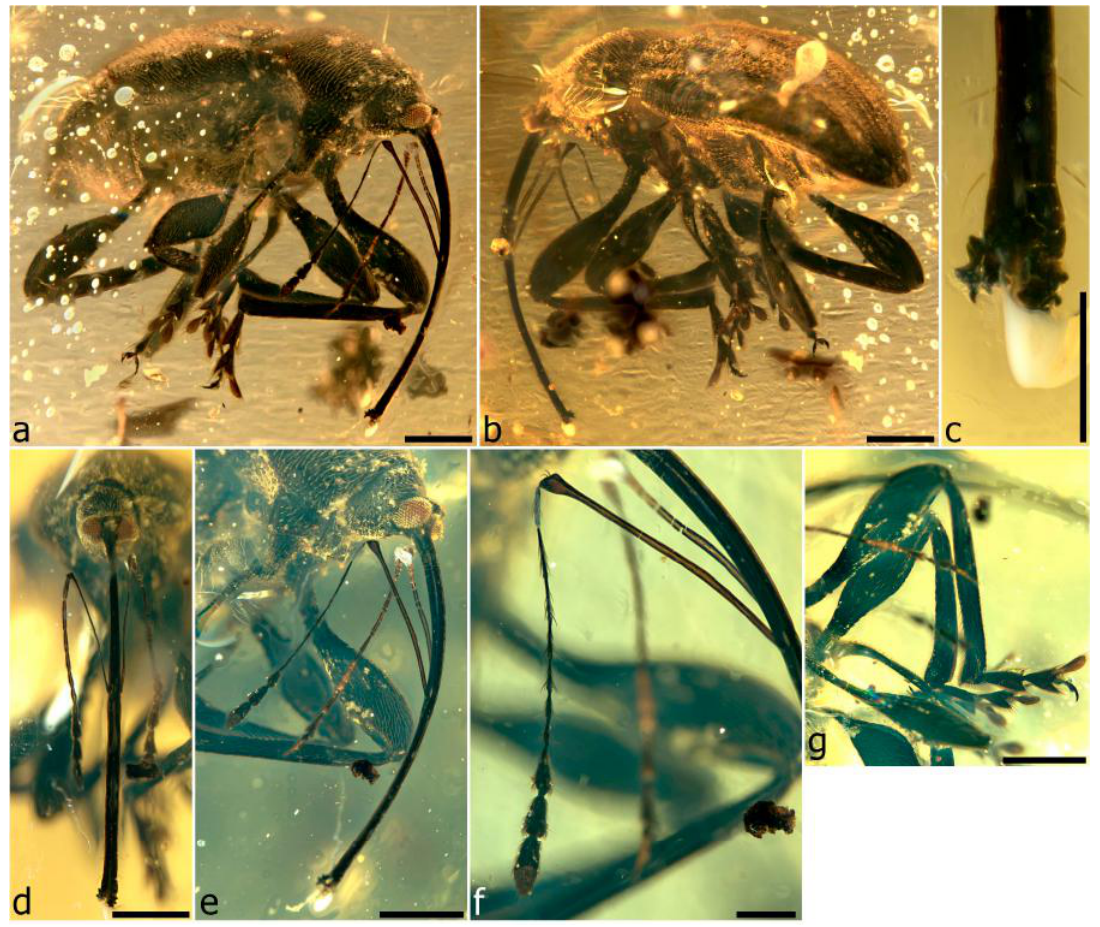
Figure 59. Mekorhamphus beatae sp. n., paratype. Habitus, right lateral ( a ); habitus, left lateral ( b ); apex of rostrum and mandibles ( c ); head and antennae, frontal ( d ); head and prothorax, right lateral ( e ); right antenna, lateral ( f ); anterior legs ( g ). Scale bars: 0.5 mm (a,b,d,e,g); 0.2 mm (c,f).